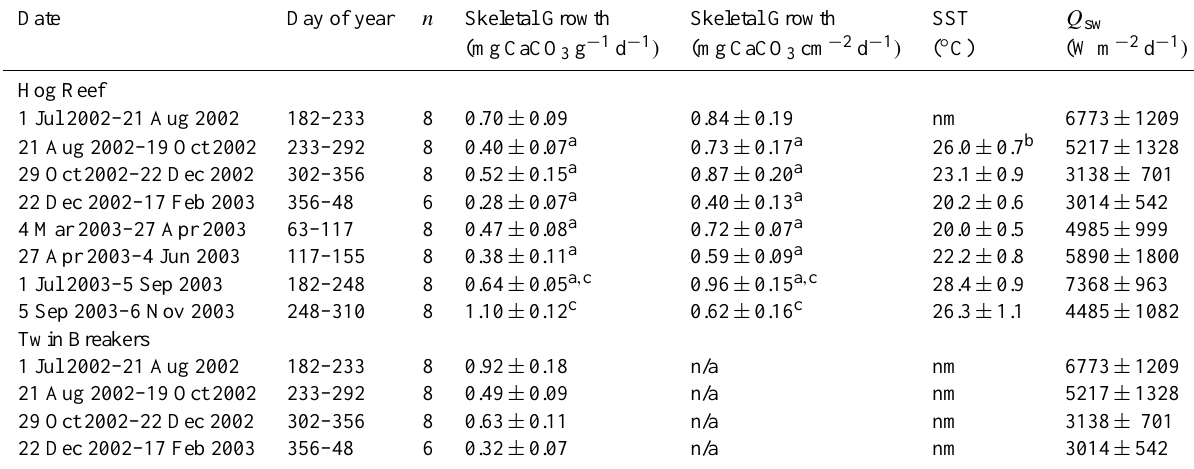
Table 2. Note: A number of incorrect rates and day of year values were mistakenly published in Table 2 of the paper. The correct skeletal growth rates that were used in the published paper text and figures are tabulated in Table 2 below. In addition, we have added the skeletal growth rate values from Twin Breakers (Amat and Bates,